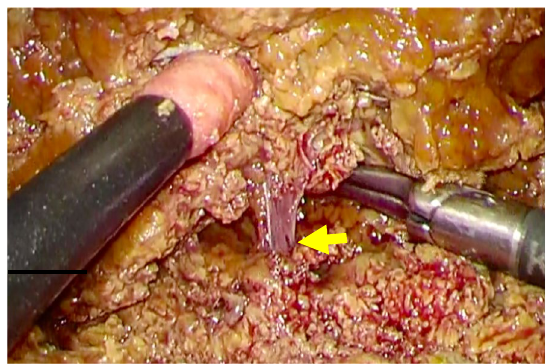
Fig. 5 Laparoscopic image of the surgical field. A small laceration without hemorrhage was seen in the wall of the vein on the hepatic resection surface, which appeared to have been under the tumor